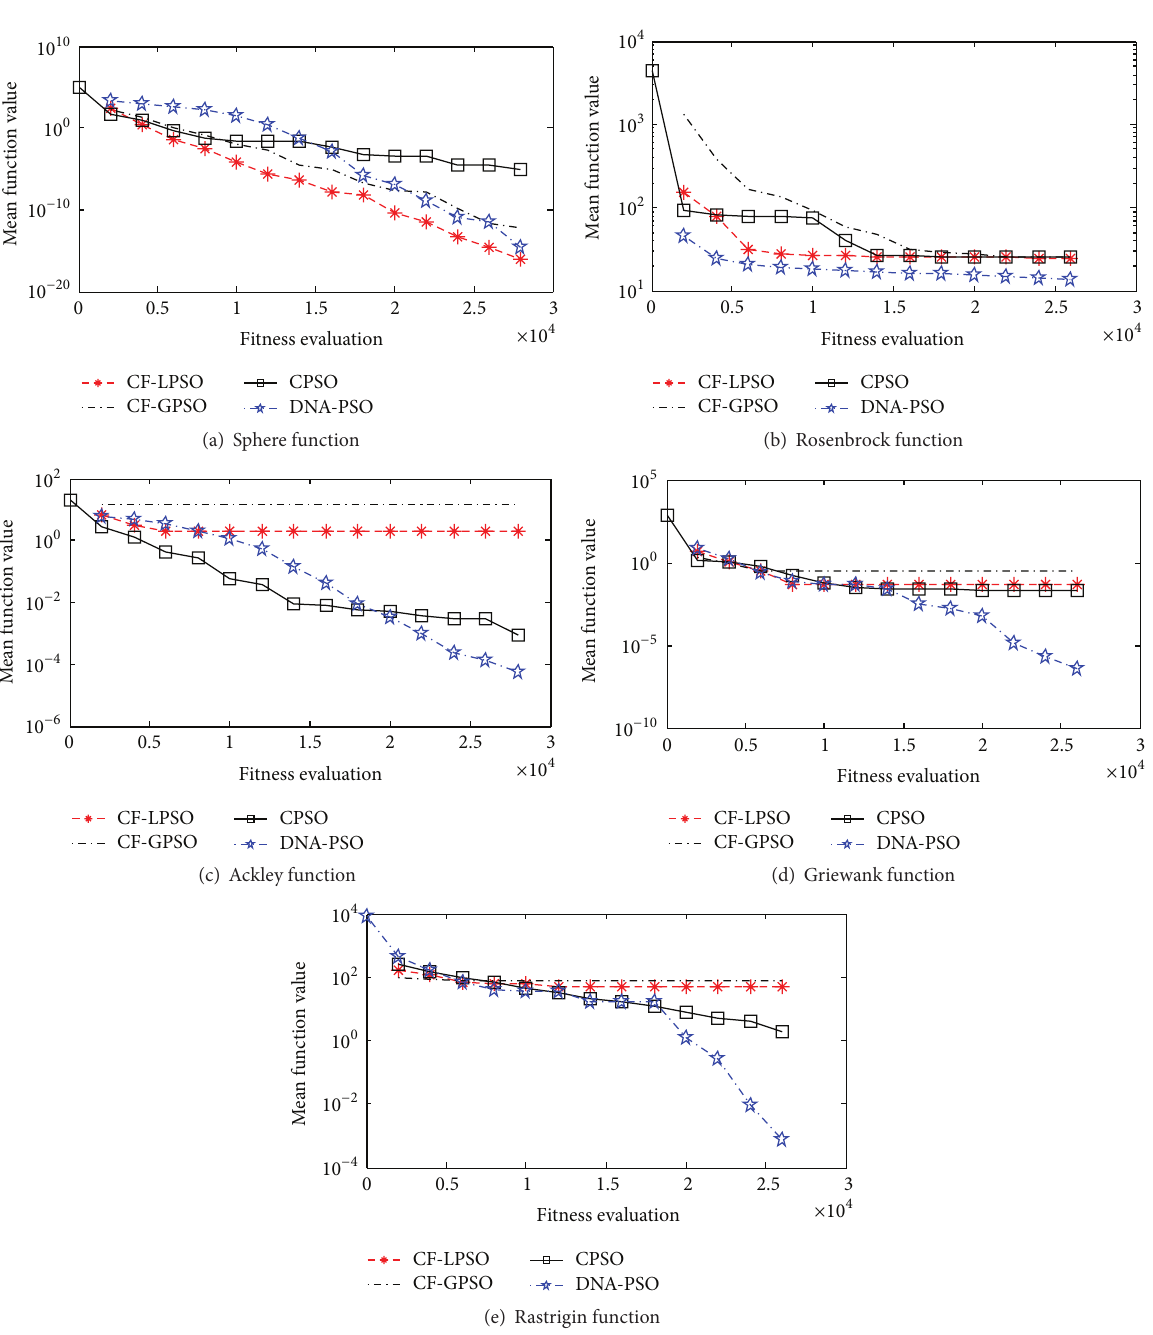
Figure 4: Nonrotated function convergence